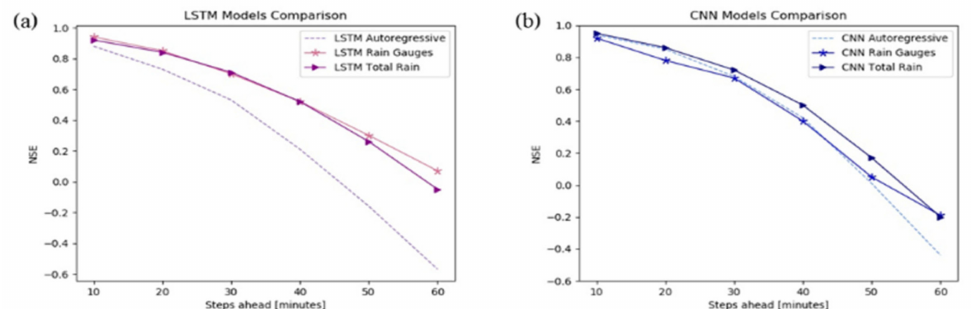
Figure 9. NSE over the forecasting horizon h of LSTM ( a ) and CNN ( b ) predictors for the floods of the Lura River: dashed lines represent autoregressive models and solid lines represent multivariable models with markers for the rain gauges and total rain